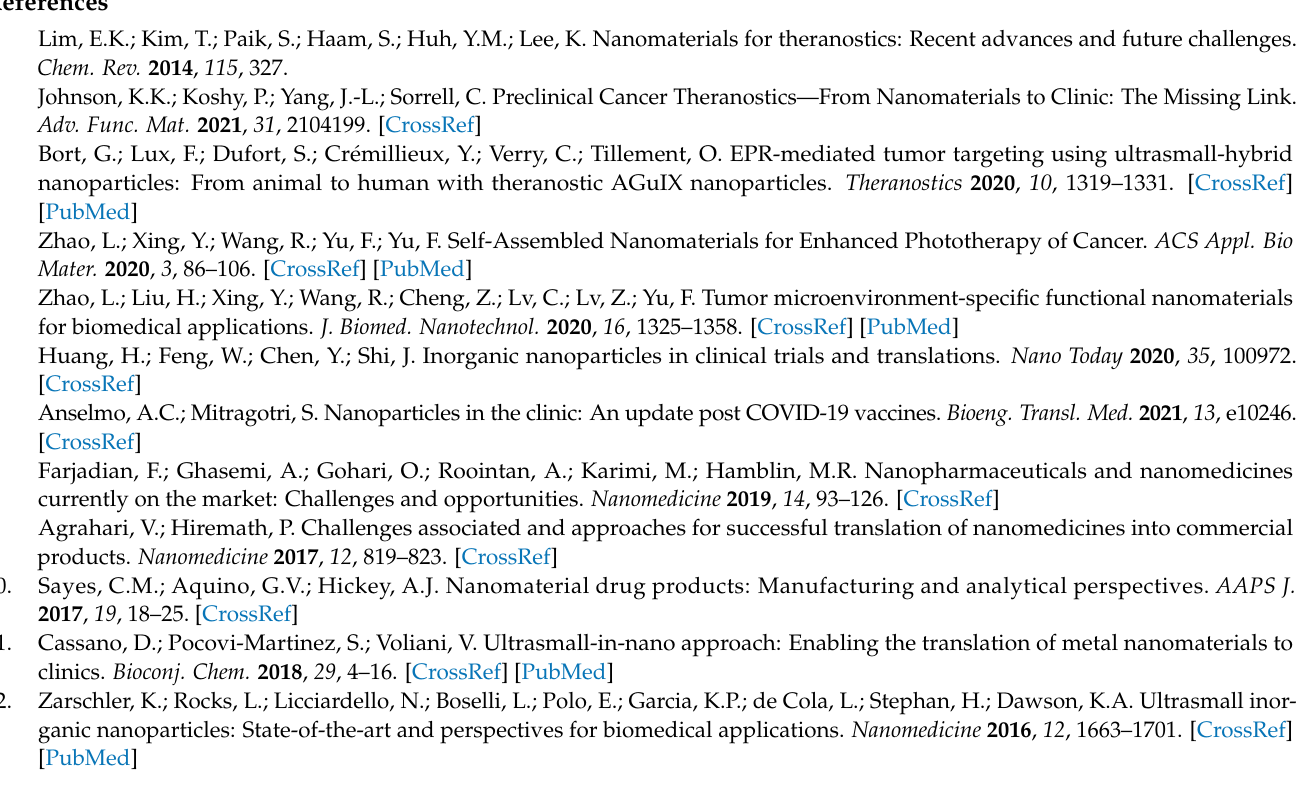
Figure S2: AGuIX main characterizations; Figure S3: Quantification of uncomplexed DOTAGA; Figure S4: Chemical structures of the fragments identified at HPLC peak 1; Figure S5: Chemical structures of the fragments identified at HPLC peak 2; Figure S6: Chemical structures of the fragments identified at HPLC peak 3; Figure S7: Chemical structures of the fragments identified at HPLC peak 4; Figure S8: Chemical structures of the fragments identified at HPLC peak 6; Figure S9: Chemical structures of the fragments identified at HPLC peak 7; Figure S10: MS spectra comparison of HPLC peak 7 (Tr = 4.05 min) and DOTAGA(Gd) control